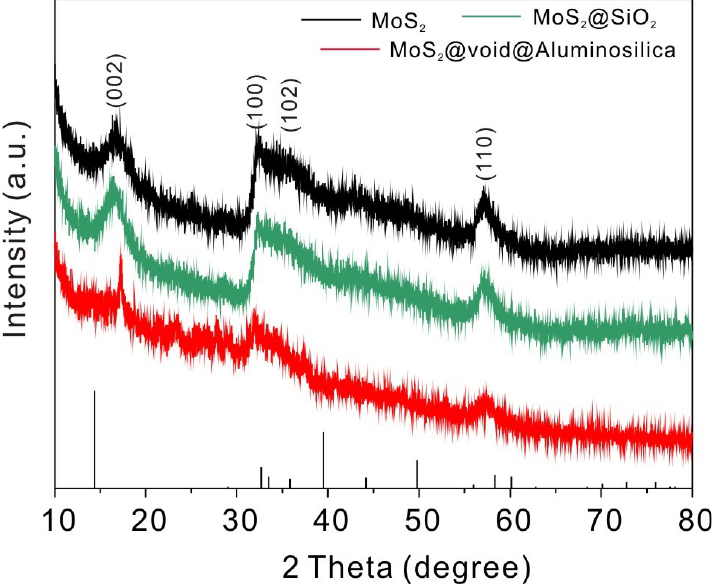
Figure 2. XRD pattern of the MoS 2 microspheres, the MoS 2 @SiO 2 microspheres, and